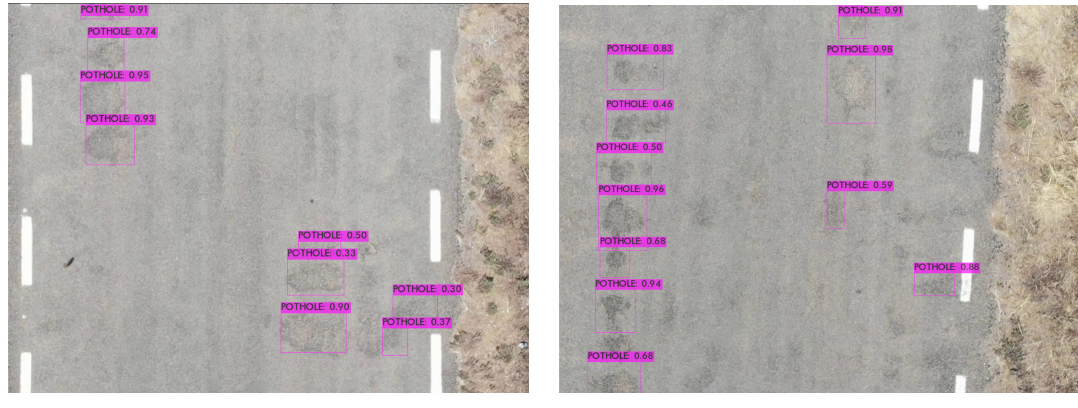
Figure A4. Detection results.